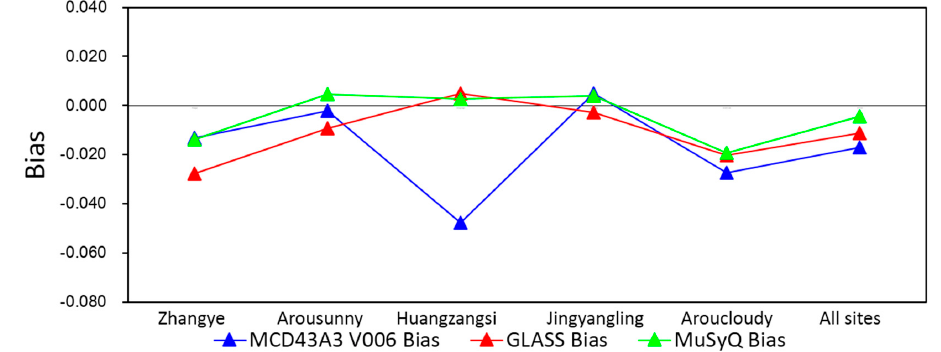
Figure 8. The comparisons of the Biases between MCD43A3 (V006), GLASS and MuSyQ albedos from the multi-scale validation.